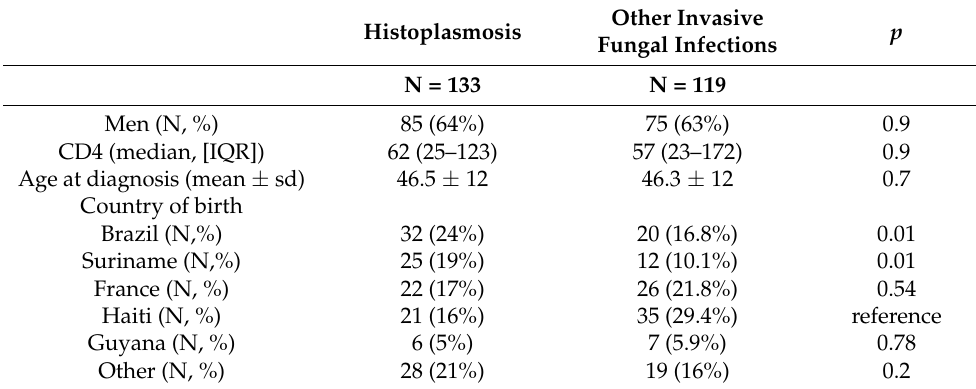
Table 3. Differences between histoplasmosis and other invasive fungal